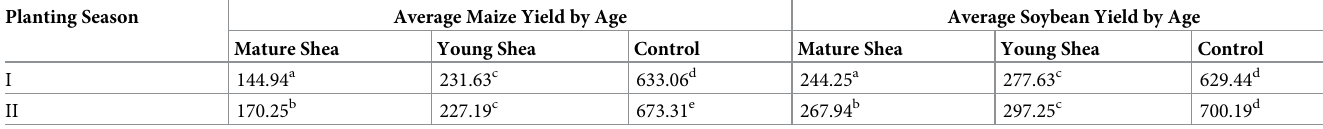
Table 4. Seasonal variation in yield of Maize and Soybeans by Shea age. Planting